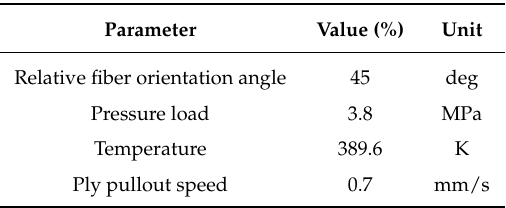
Table 5. Constant values of